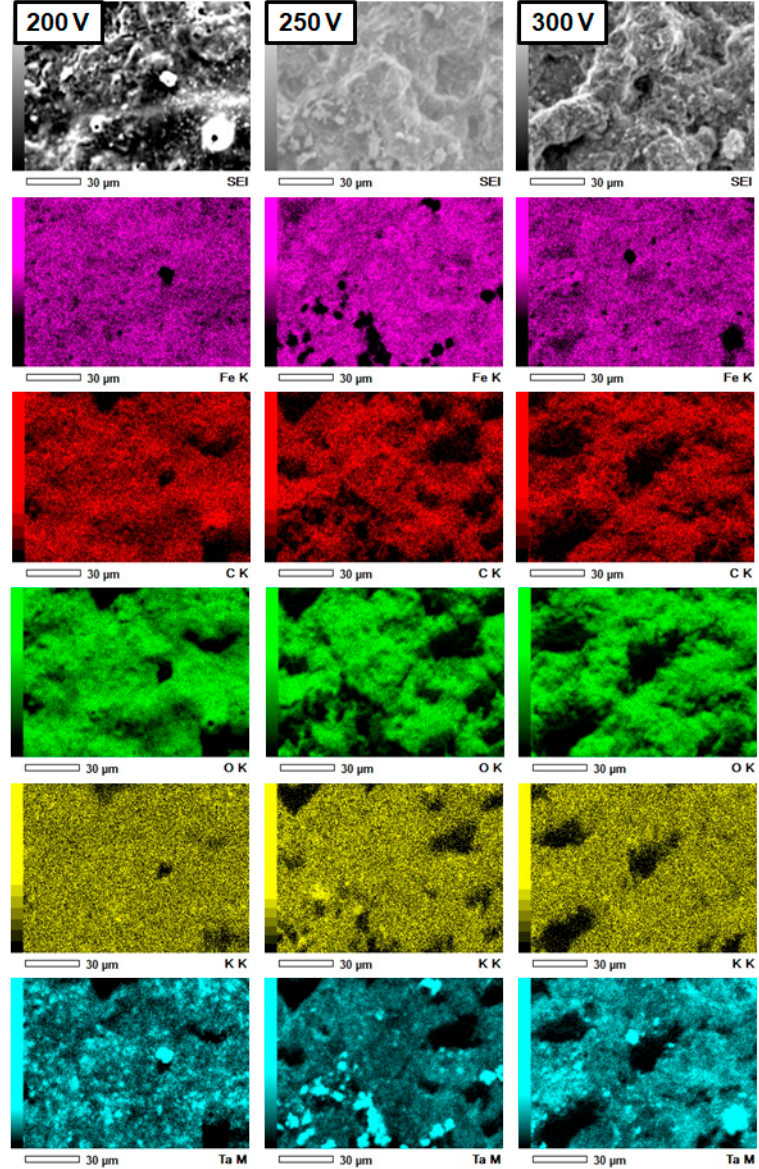
Figure 3. EDS chemical mapping of the elements presented in the samples’ surfaces (SEI: Secondary Electron Image; Fe, C, O, and K mappings from the K electron shell; Ta mapping from the M electron shell).